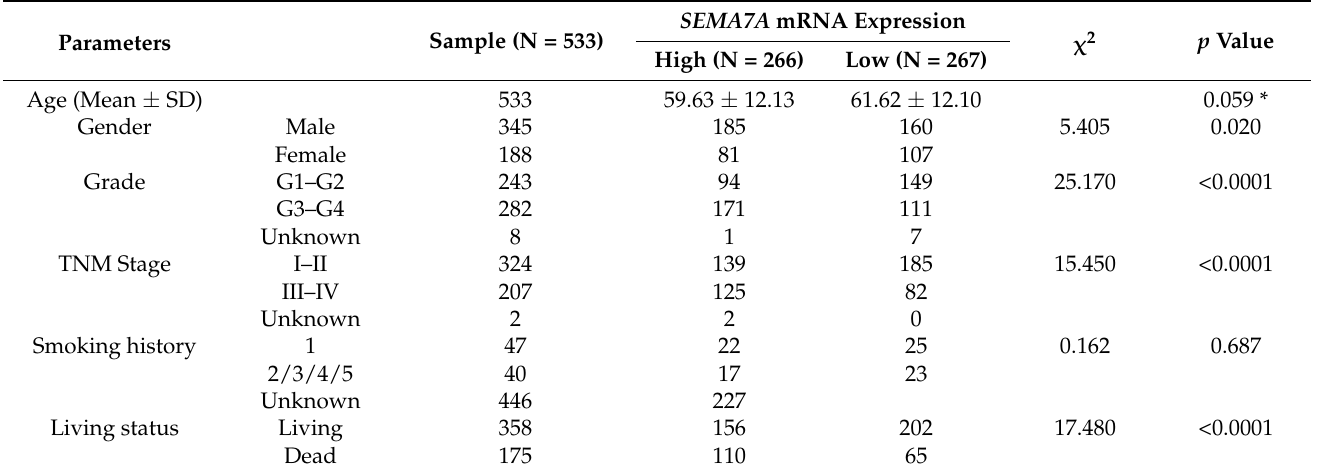
Table 1. The association between SEMA7A expression and the demographic and clinicopathological parameters of patients with primary KIRC in the